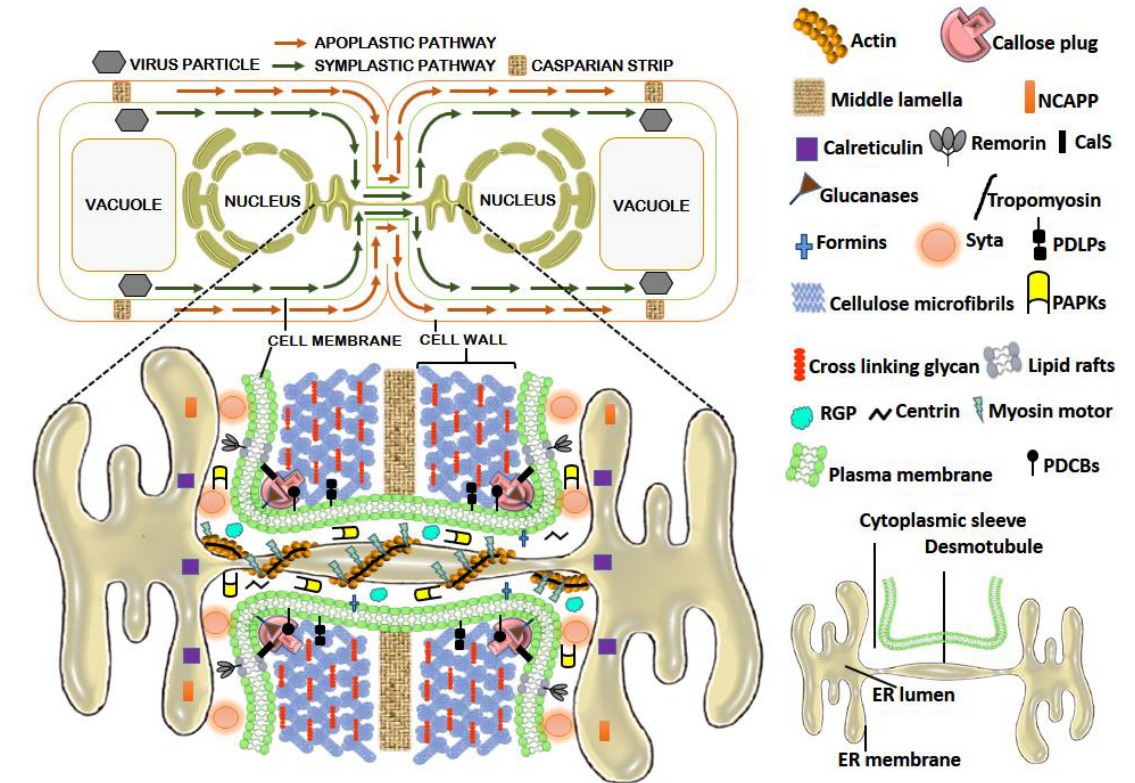
Figure 1. The symplastic and apoplastic pathways between adjacent plant cells and the model illustrating plasmodesmata (PD) structure with-associated cytoskeletal components and proteins governing PD permeability. Abbreviations: CalS— callose synthases; NCAPP—non-cell-autonomous pathway proteins; PAPK—plasmodesmal-associated protein kinase; PDCB—plasmodesmata-associated callose-binding proteins; PDLP—plasmodesmata-located proteins; RGP—reversibly glycosylated polypeptide; Syta—synaptotagmin A.